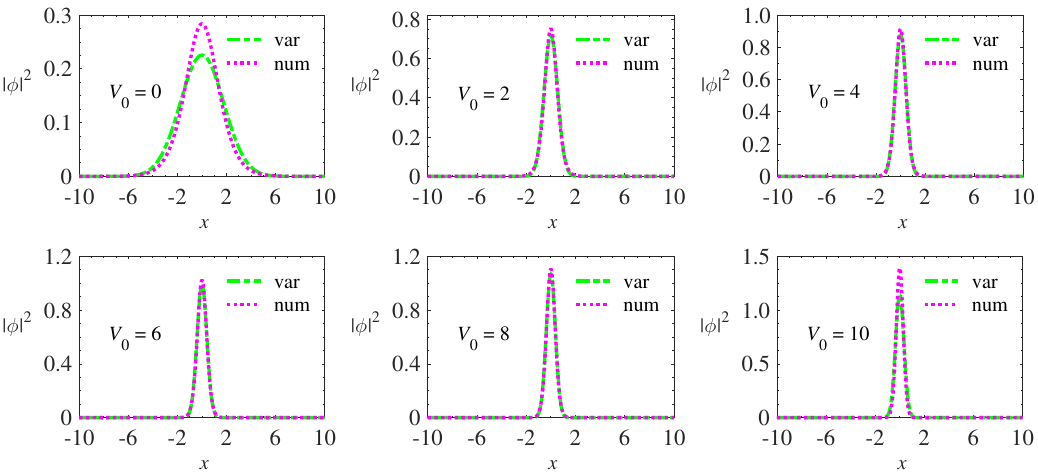
Figure 2. Variational and numerical results of the Equation (16) for different values of the Pöschl–Teller potential amplitude. It is noticed that, as the depth of the potential increases, the wave function width decreases and its amplitude increases, preserving the normalization. The nonlinearity coefficient remained fixed ( g = 1) in all simulations.